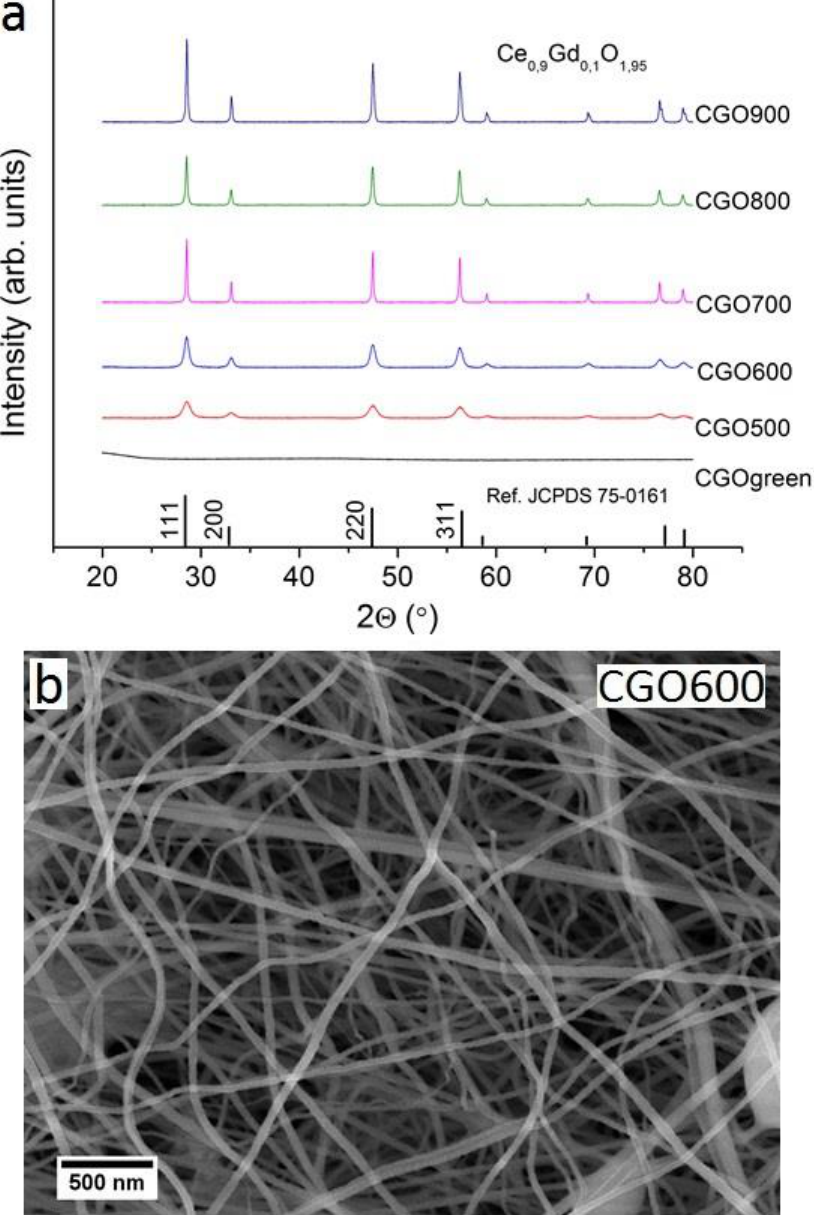
Figure 1. ( a ) XRD pattern of CGO as electrospun (green) and calcinated at different temperatures; ( b ) SEM image of nanofibers calcinated at 600 °C.